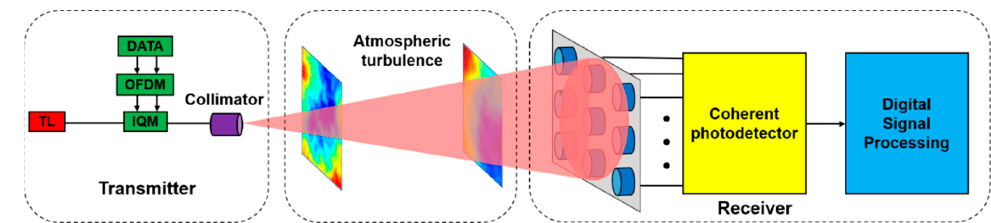
Figure 1. Schematic diagram of the spatial diversity reception FSO communication system using OFDM signals.